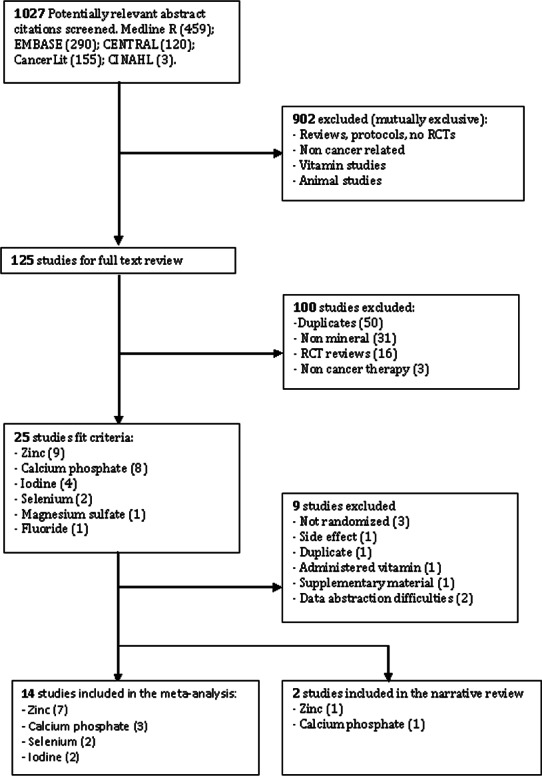
A flow diagram of search results based on the PRISMA statement (Moher et al., 2009).